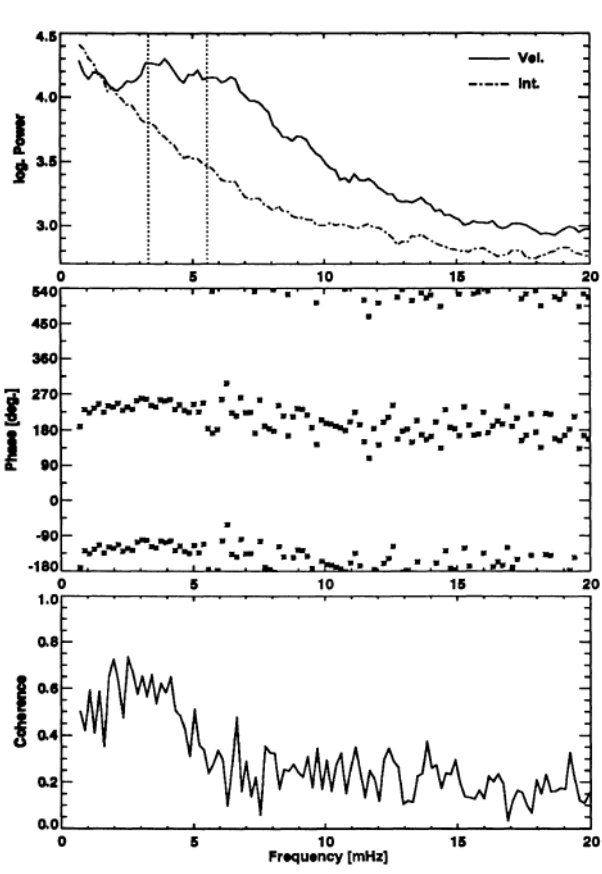
Figure 14: Oscillations observations in He i 1083 nm. Both velocity and intensity oscillations were seen, but power peaks are only visible in the velocity signal. The coherence is high at low frequencies, but the phase shift is very different from the adiabatic value of 90 degrees. Image reproduced with permission from Fleck et al. (1994), copyright by